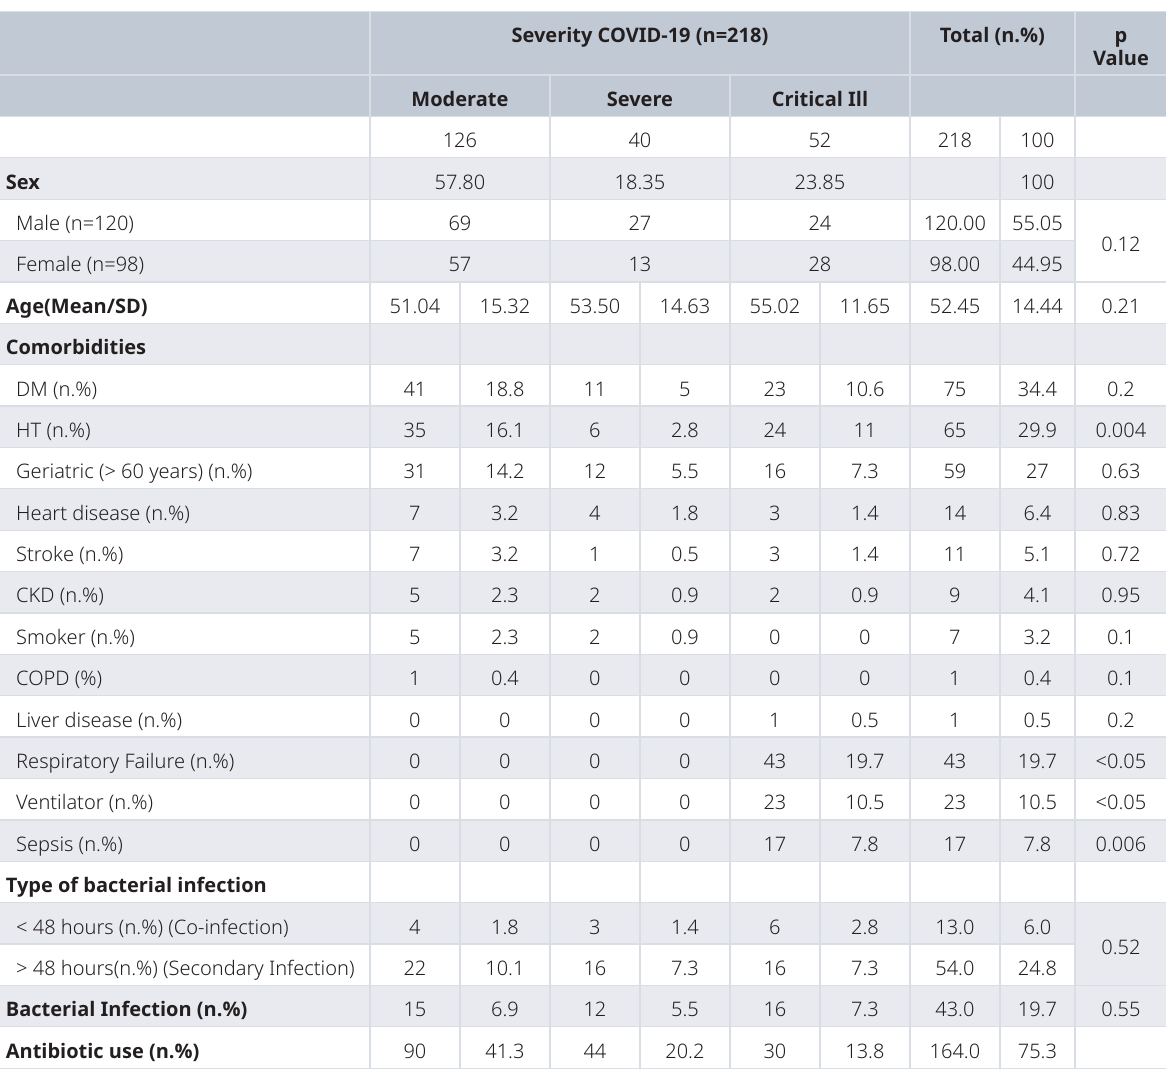
Table 1. Baseline Characteristics of